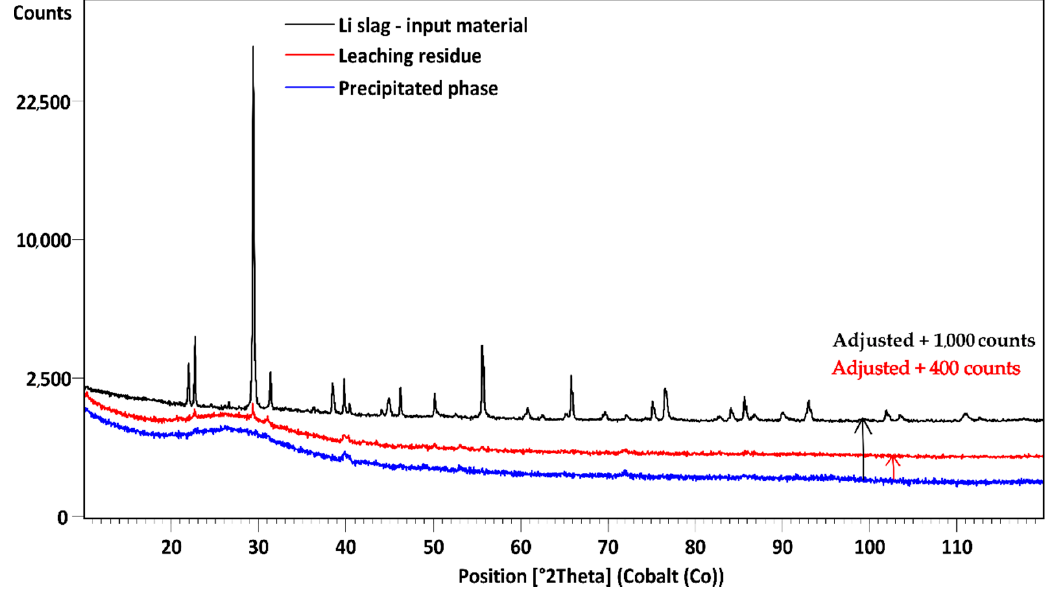
Figure 20. XRD analysis of input slag sample (black) leaching residue after leaching (red) and precipitated phase (blue).